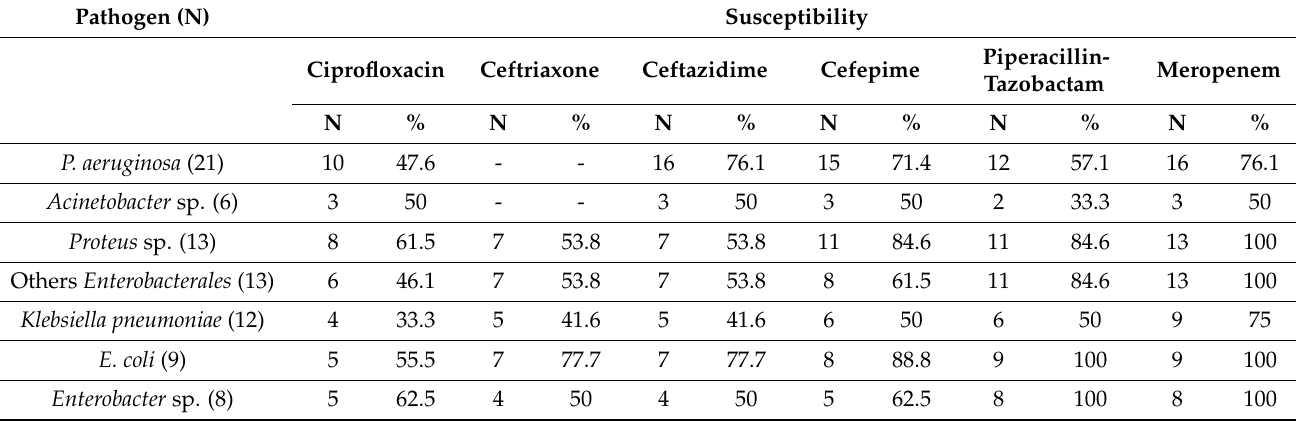
Table 3. Susceptibility pattern of the Gram-negative